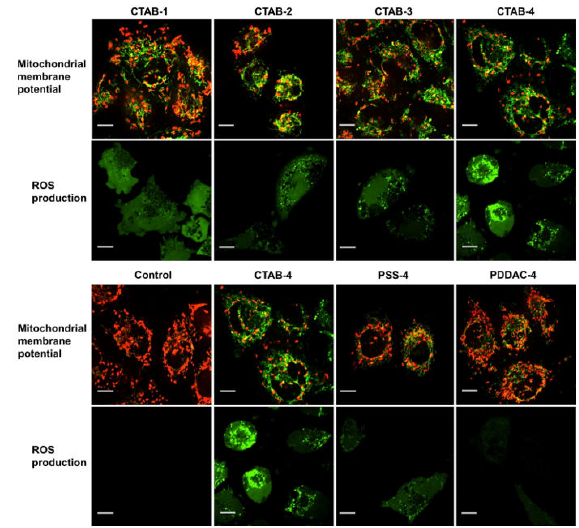
Figure 17. Cytotoxicity of treated cells by Au NRs. ( A ) cholecystokinin CCK-8 assays of CTAB-coated Au NRs ( B ) AR 1 Au NRs ( C ) AR 1 4 in Au NRs ( D ) CCK-8 assays of Au NRs [137]. Reprinted with permission from ref. [137]. Copyright 4 2010 Biomaterials.